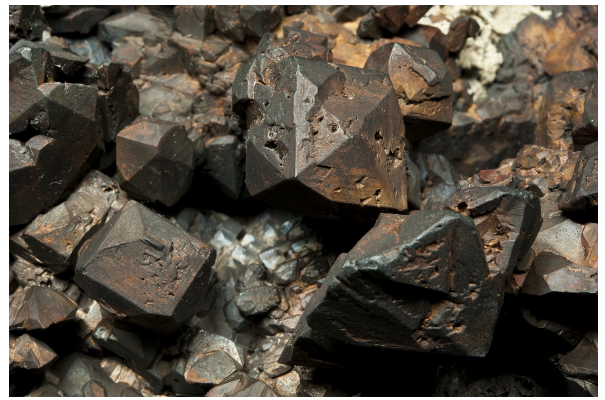
Figure 2. Close-up view of the Michigan copper sample (Sor- bonne collection no. 9723). The natural { 410 } tetrahexahedral cop- per crystals are clearly visible. Field of view: 7 × 4 . 6cm. Photo: Alain